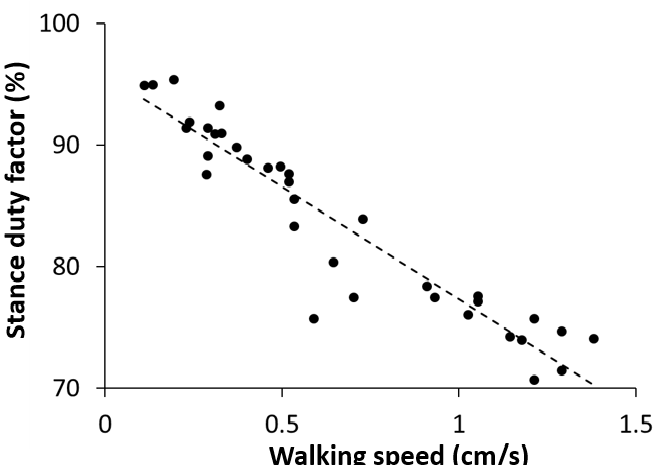
Figure 7. Measurement data representing the stance duty factor, averaged over all six legs, accord- ing to the walking speed. The diagonal dashed line is the least-squares regression line (R 2 = 0.8895, p < 0.001). p <